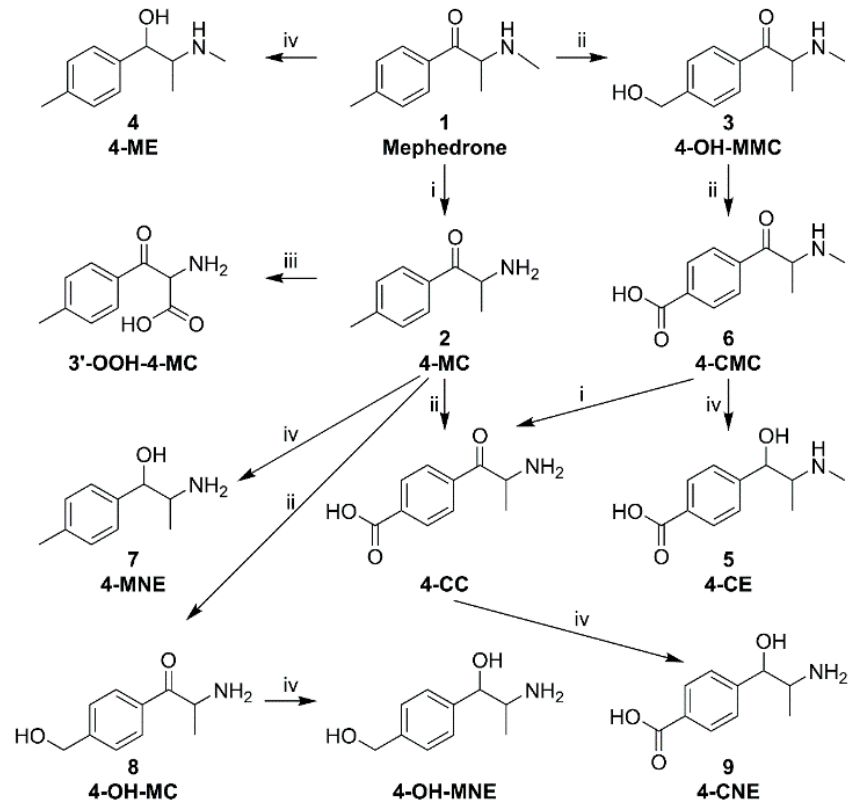
Figure 2. Scheme of phase I biotransformation of mephedrone: (i) oxidative N -demethylation, (ii) oxidation of the 4-methyl group, (iii) ω -oxidation at the 3 ′ position, and (iv) reduction of the carbonyl group.